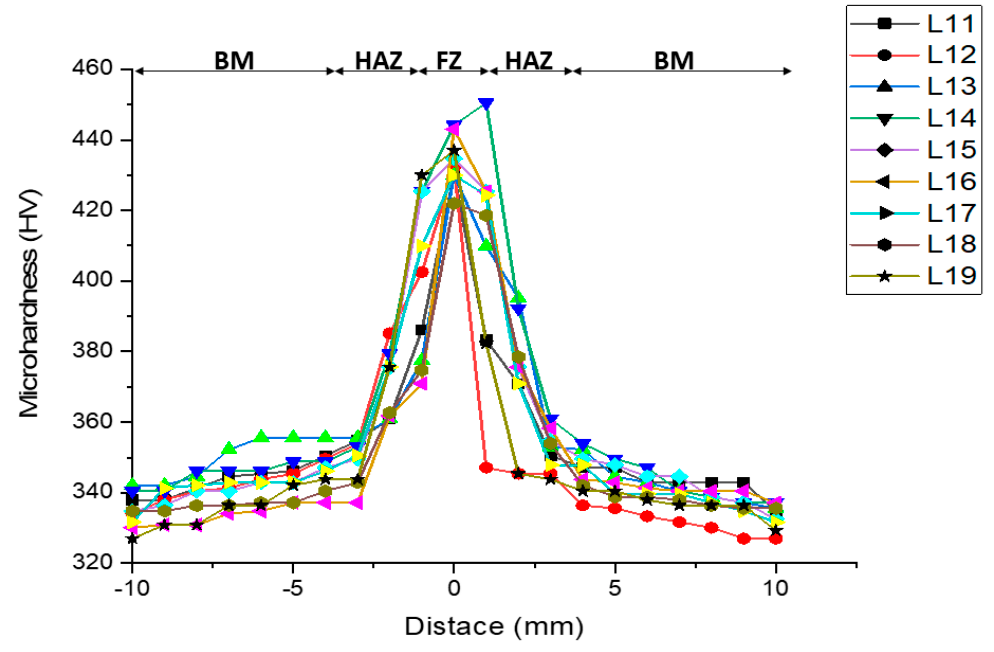
Figure 4. Microhardness profile of welded samples.